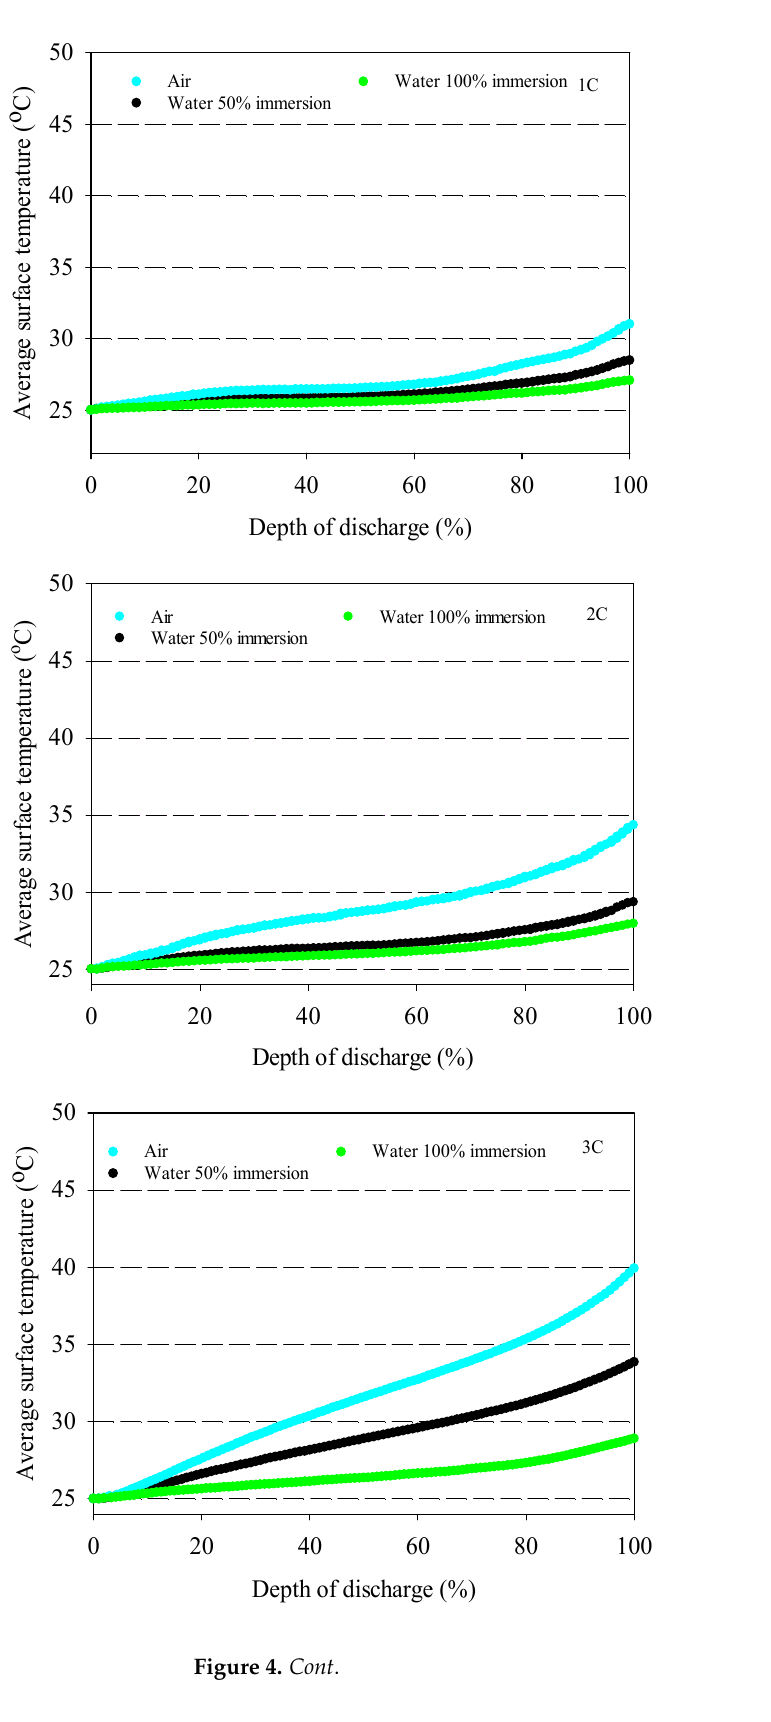
( d ) Figure 4. The effect of fluid type and immersion ratio on average battery surface temperature for various discharge rates of ( a ) 1C, ( b ) 2C, ( c ) 3C and ( d ) 4C (T inlet = 25 °C). Figure 5 demonstrates the variation of maximum battery surface temperatures with the depth of discharge for different fluid types, immersion ratios and various discharge rates, respectively. It can be revealed that there is nonhomogeneous temperature distribu- tion on the battery surface during discharge, and it rises with an increment of discharge rate. According to Figure 5, the maximum battery surface temperatures are 33.32 °C, 42.28 °C and 45.61 °C for 100% water immersion, 50% water immersion and air at the end of 4C discharge rate, respectively. The maximum battery surface temperatures are observed for the positions of T 1 , T 2 and T 1 for 100% water immersion, 50% water immersion and air at the end of discharge. It should be noted that the maximum temperatures are observed in the location near the tabs. It can be concluded that the 100% immersion technique can keep battery temperature in the desired range for all considered discharge rates, whereas the other techniques are only appropriate for lower discharge rates (1–2C). Temperature curves depict that the maximum temperature of the battery is significantly affected by immersion since half of the test section is filled with distilled water. Moreover, this situa- tion can also be observed at the minimum temperatures, and the results are given in Table 3.